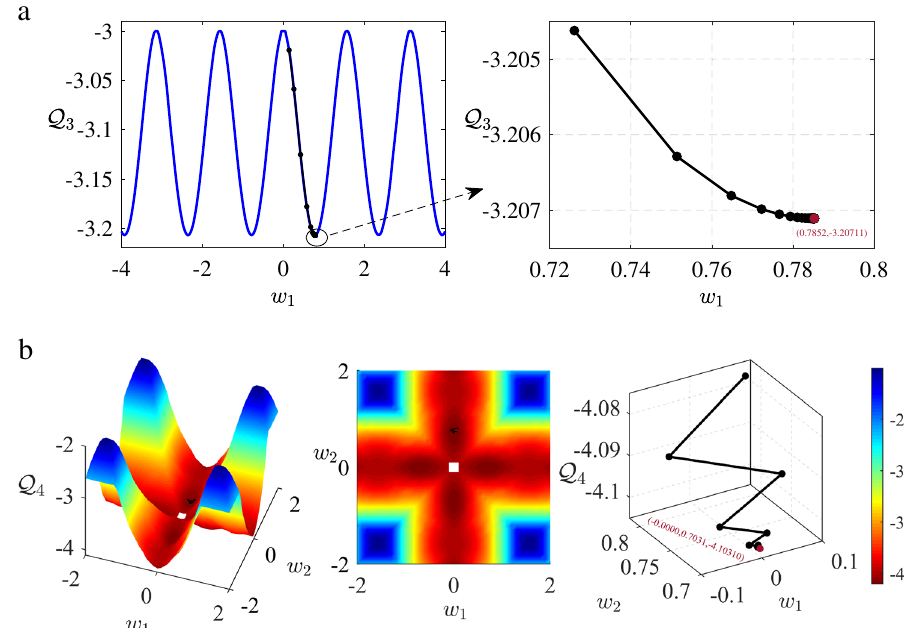
Fig. 5 Trajectories of ground state energy from our algorithm. Two models from Table 3 are selected. a Has two subplots, and the right panel gives a more detailed view of the trajectory in the left one when ground state energy density converges to the minimum. b Gives two different views for the ground state energy surface, while the last panel shows the trajectory in parameter space. a No. 3 in Table 3, L ¼ (cid:3) 3 . b No. 6 in Table 3, L ¼ (cid:3) 4